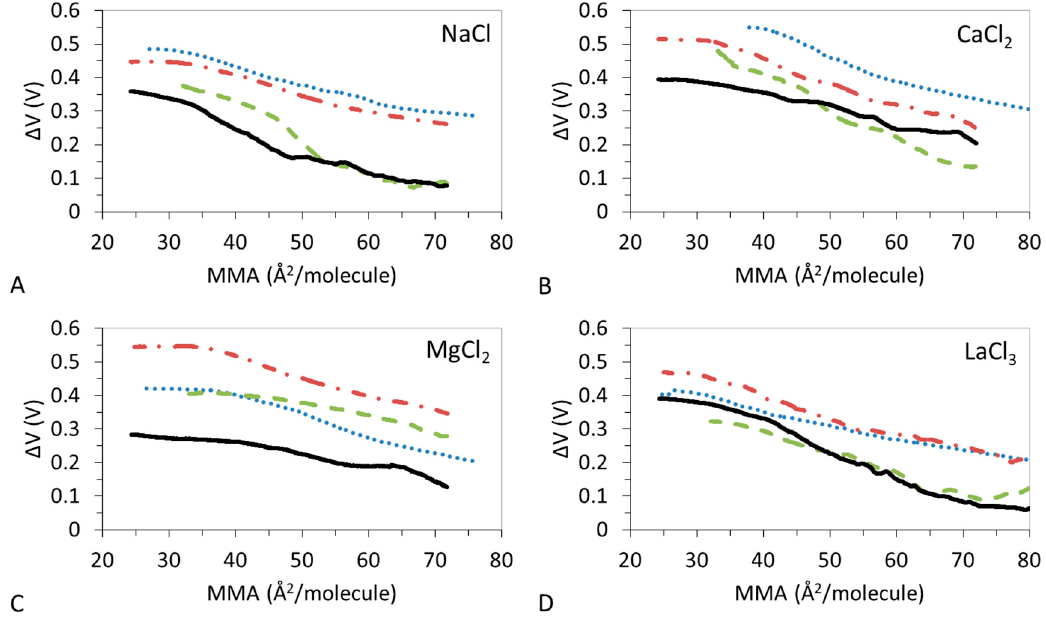
Figure 2. Surface potential-area ( ∆ V –A) isotherms for DPPC:DPPS:CHOL spread onto solutions I = 15 mM ( A ) NaCl ( B ) CaCl 2 ( C ) MgCl 2 ( D ) LaCl 3 . DPPC:DPPS (blue dotted line), DPPC:DPPS:CHOL-30 (red dash-dotted line), DPPC:DPPS:CHOL-70 (green dashed line), CHOL